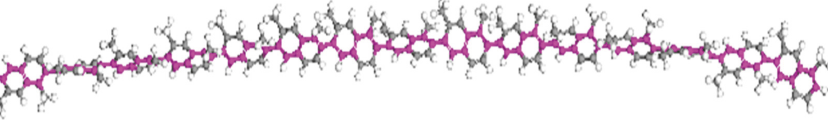
Figure 1: Long chain of colloid for the degree of polymerization at 15.